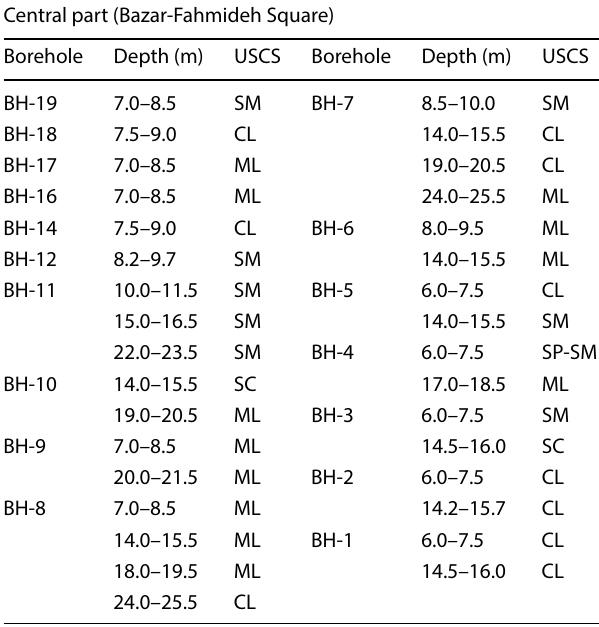
Table 3 Geotechnical specifications of alluvial layers at different depths in the central part of TML2 Central part (Bazar-Fahmideh Square) Borehole